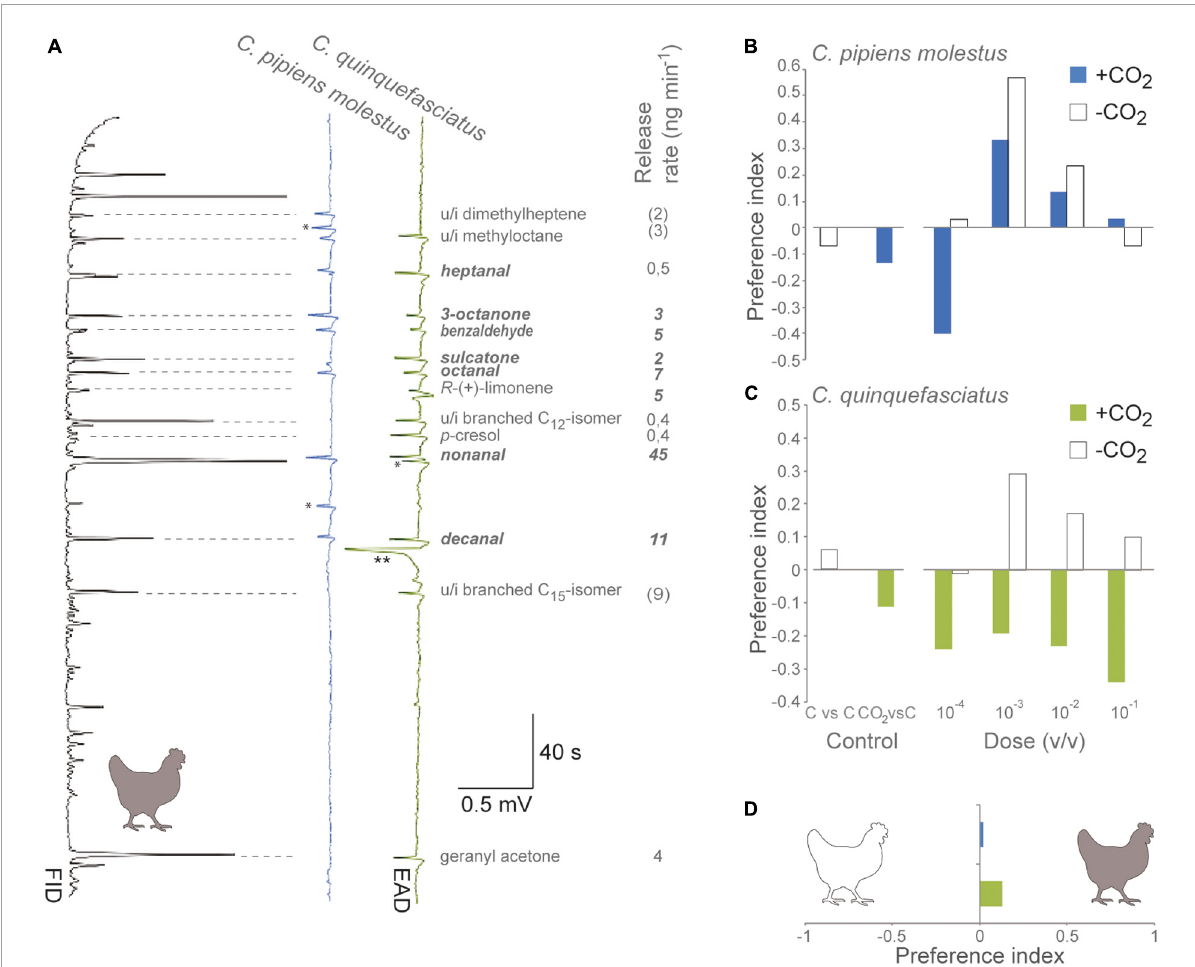
FIGURE1 Host-seeking Culex pipiens molestus and Culex quinquefasciatus respond to chicken odor. (A) Combined gas chromatography and electroantennographic detection (GC-EAD) analyses of the two mosquito species identify the bioactive volatile organic compounds present in the headspace of chickens. Electroantennographic detection traces depict voltage changes (mV) in response to the bioactive compounds eluting from the GC, which are registered by the flame ionization detector. Asterisks indicate non-reproducible physiological responses. The identity and release rate of the bioactive compounds are shown to the right. u/i: unidentified volatile organic compound. (B,C) A synthetic blend composed of the bioactive compounds, in their natural ratio (A) , elicited attraction (positive preference indices) of both Culex spp. in a Y-tube olfactometer, which was dependent on the presence or absence of carbon dioxide (CO 2 ), as demonstrated using binomial regression. Mosquitoes demonstrated no significant preference for either side of the Y-tube olfactometer in the presence of a control (pentane) (C vs. C) or in the presence of CO 2 in one of the upwind arms (CO 2 vs. C) as shown on the left of the graph. The preference index was calculated as (T − C)/(T + C), where T is the number of mosquitoes associated with the test odor, and C the number of mosquitoes associated with the control. (D) The two Culex species were unable to discriminate between the natural headspace (filled) and the synthetic blend (open) of chicken odor, when assessed in a two-choice olfactometer (two sample t -test).